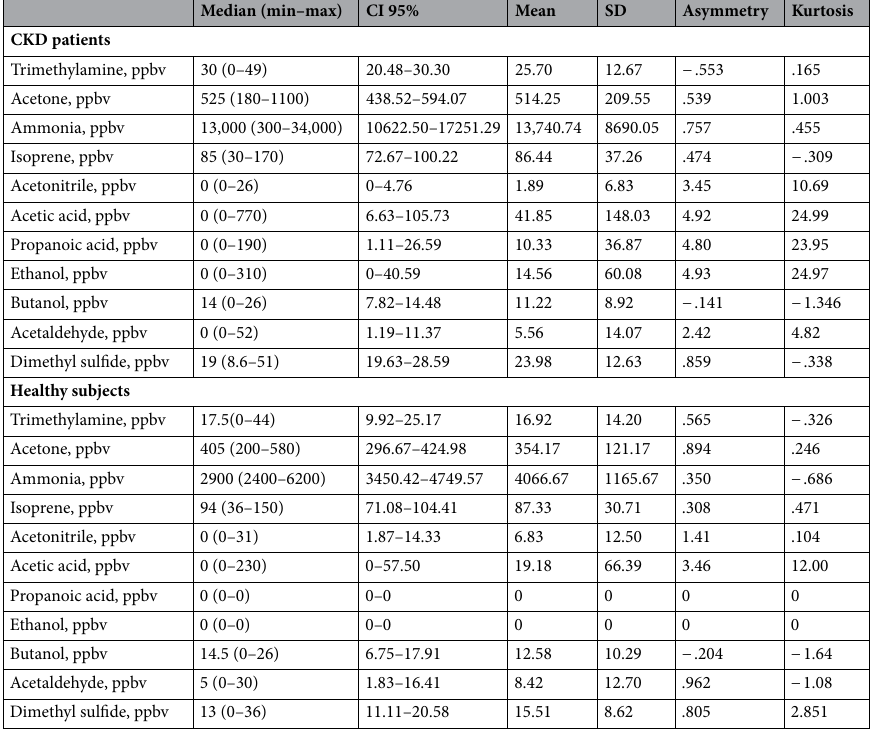
Table 1. Descriptive statistic of target compounds. CI confidence interval; SD standard deviation.